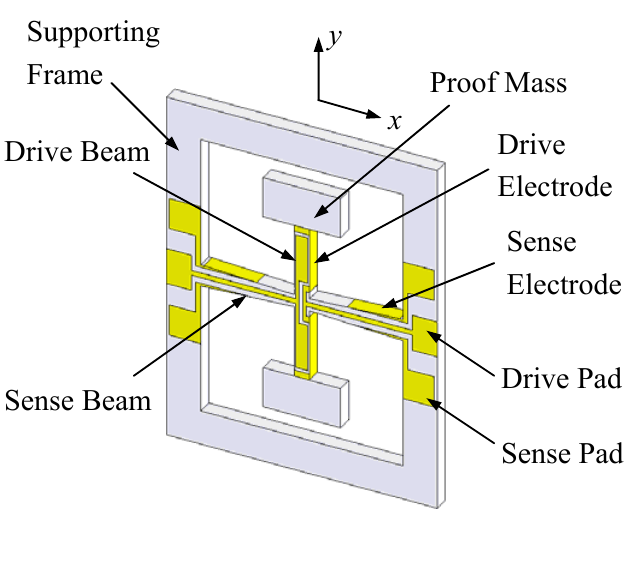
Figure 1. The gyroscope’s structure.